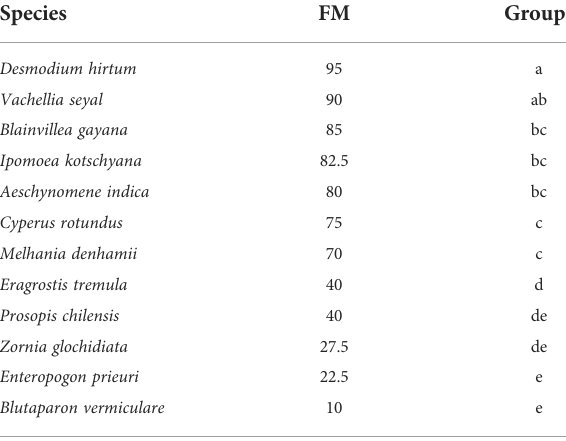
TABLE 9 Tree – herbaceous plant groupings according to mycorrhization frequencies of natural living roots.